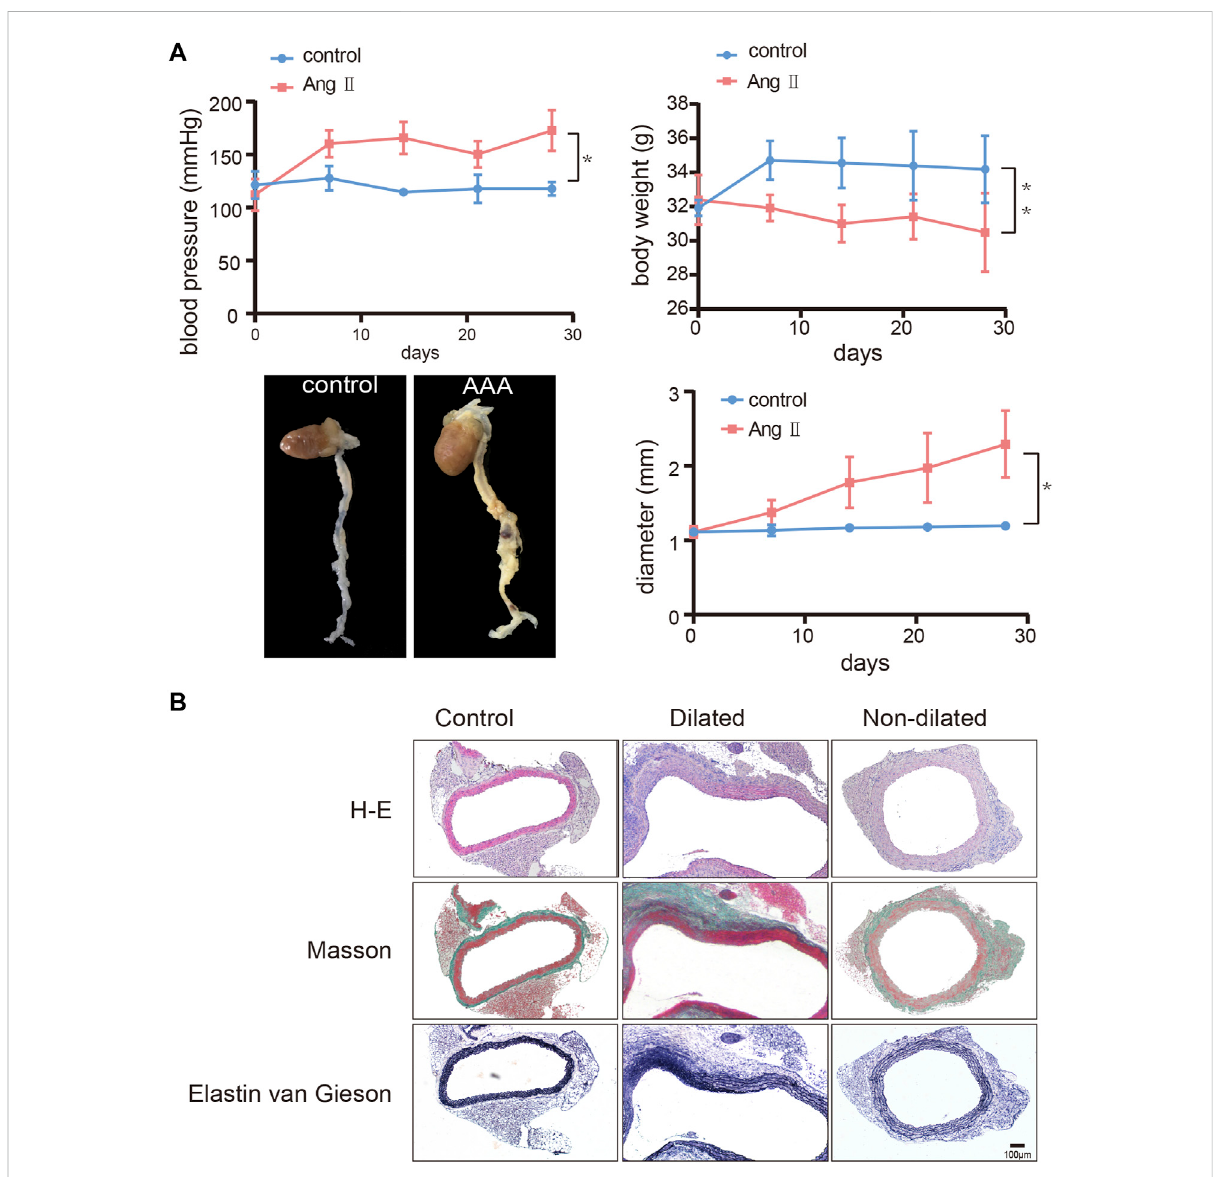
Constructionoftheabdominalaorticaneurysm(AAA)mousemodel. (A) Changeofbloodpressure,bodyweight,anddiameteroftheabdominal aorta over 28 days and representative imagesof harvested hearts and vessels from control and AAA mice. N = 6, results are expressed as the mean ± SD. * p < 0.05, ** p < 0.01. Data were analyzed using student t-test. Representative images of (B) H-E staining, Masson ’ s staining, and van Gieson staining of the abdominal aorta from control and AAA mice. Scale bar = 100 μ